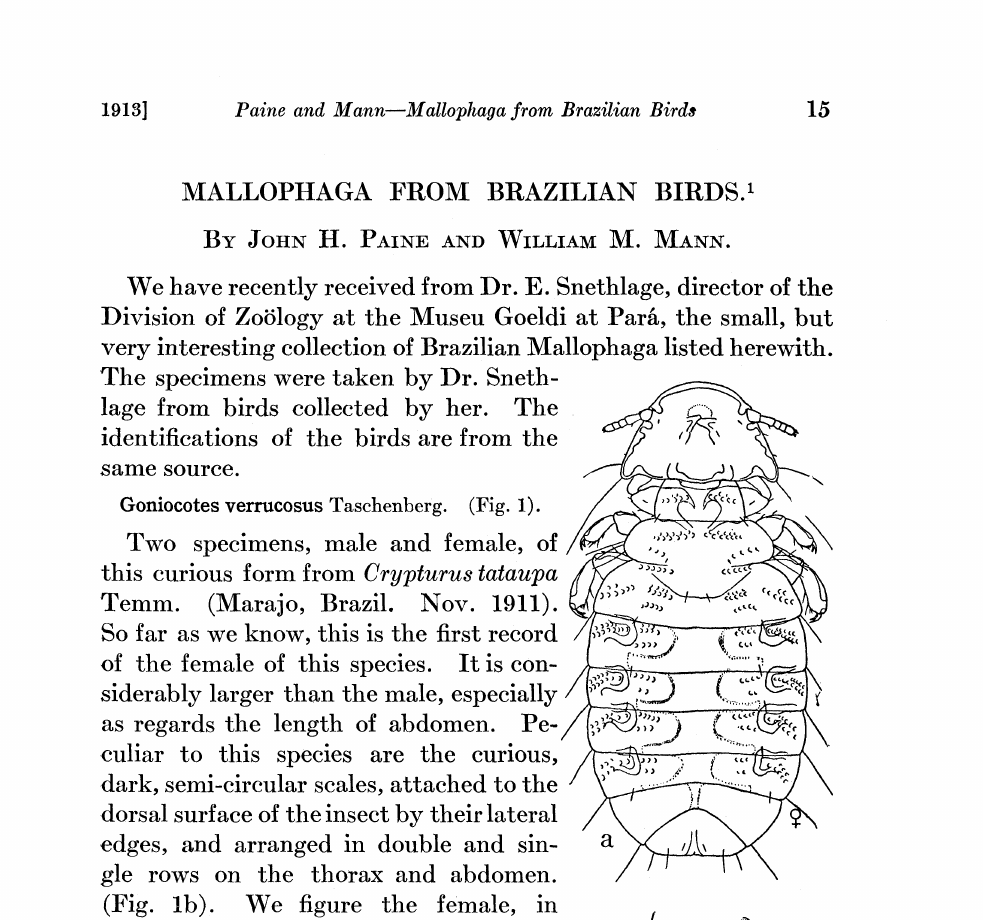
Measurements. Fig 1. Goniocotes verrucosus